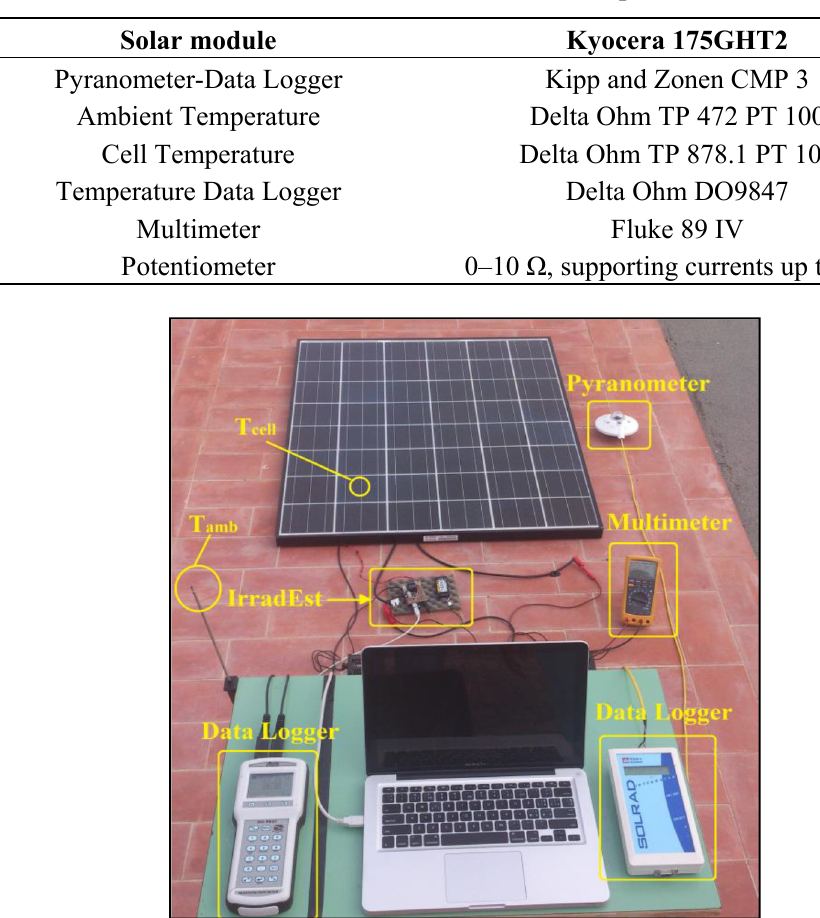
Figure 3. Experimental setup using a PV module Kyocera